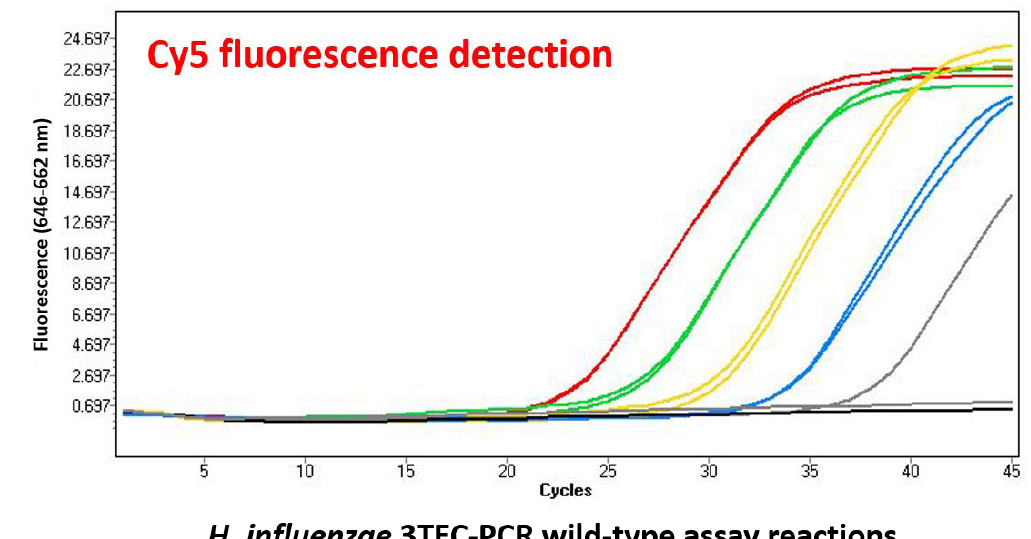
Figure 2. 3TEC-PCR singleplex detection. The H. influenzae 3TEC-PCR wild-type assay was tested with 10-fold serially diluted H. influenzae type strain genomic DNA, with a no-template control reaction performed in parallel. Resulting amplification fluorescence was recorded with the LightCycler 480 Instrument II using the Cy5 fluorescence detection channel. Genome copy concentrations tested at 10 4 (red), 10 3 (green), 10 2 (yellow), and 10 1 (blue) were successfully detected in duplicate, with one of the 10 0 (grey) duplicates detected. No signal was observed in the negative control reaction